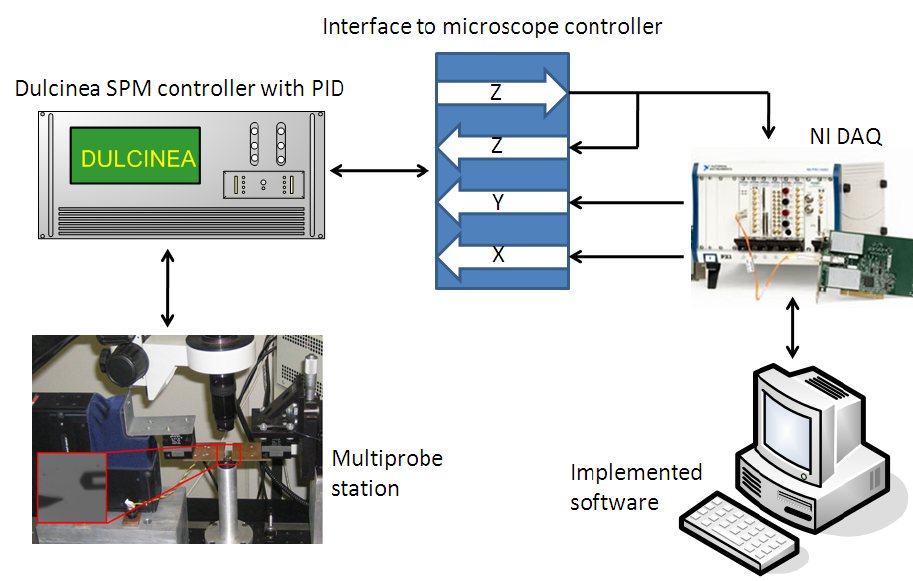
Figure 7. Experimental setup. The controllers were implemented in software; an I/O board was used as interface with the analog control of the SPM controller. The main PID control was executed in the SPM controller.